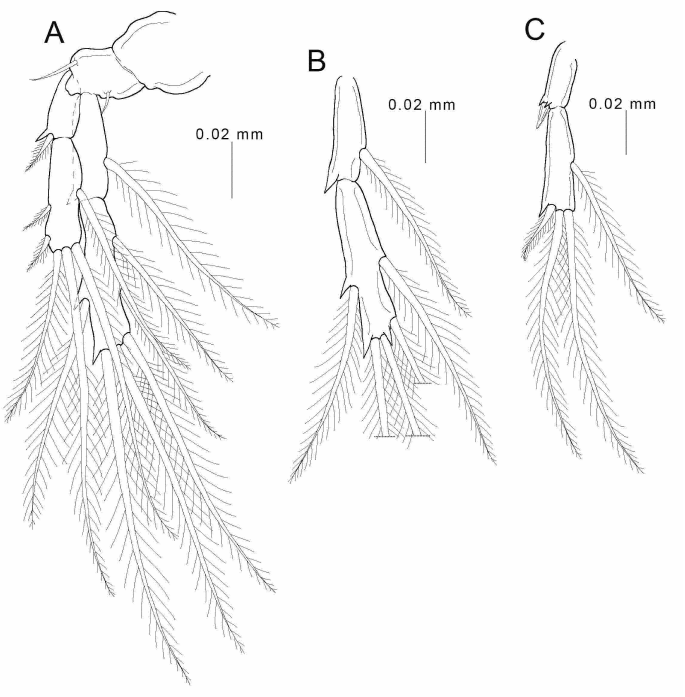
Figure 5. Female Choniomyzon taiwanensis n. sp. ( A ) Leg 1; ( B ) endopod of leg 2; ( C ) exopod of leg 2. Scale-bars: ( A – C ), 0.02 mm.